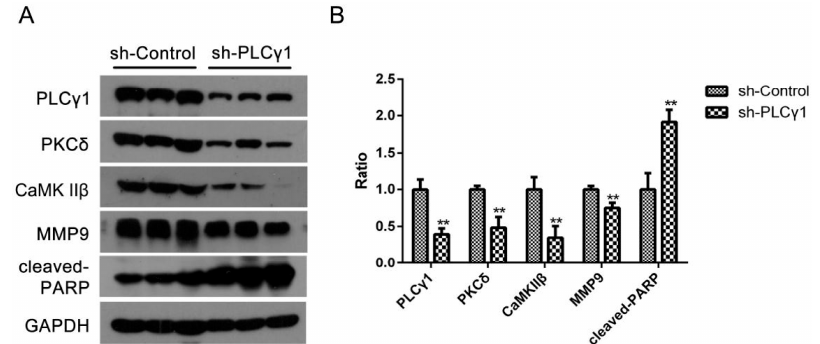
Figure 4. The expression level of PKC δ and CaMK II β in mice tumor xenograft model derived from gastric adenocarcinoma cells with the transfection of sh-PLC γ 1. Mice were injected human gastric adenocarcinoma cells, BGC-823, for 40 days, and finally sacrified. Tissue protein in subcutaneous tumor tissue was then extracted. ( A ) The expression level of PLC γ 1,PKC δ , CaMK II β , cleaved-PARP, and MMP9 in the tumor samples were detected by Western blotting analysis as described in Materials and Methods; ( B ) The histogram represents the means ± S.D. of the expression level of PLC γ 1,PKC δ , CaMK II β , cleaved-PARP, and MMP9 in the tumor samples. (** p < 0.01, versus control group).